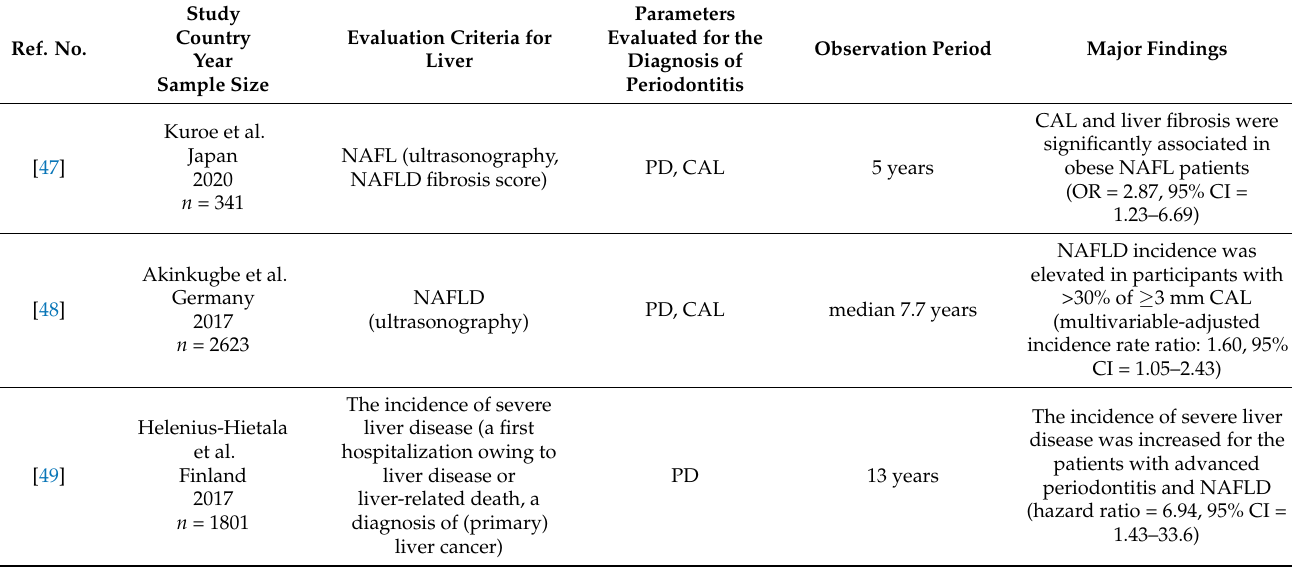
Table 2. Prospective cohort studies regarding the relationship between NAFLD and periodontal disease. Parameters Evaluation Criteria for Evaluated for the Observation Period Major Ref. No. Liver Diagnosis of Periodontitis